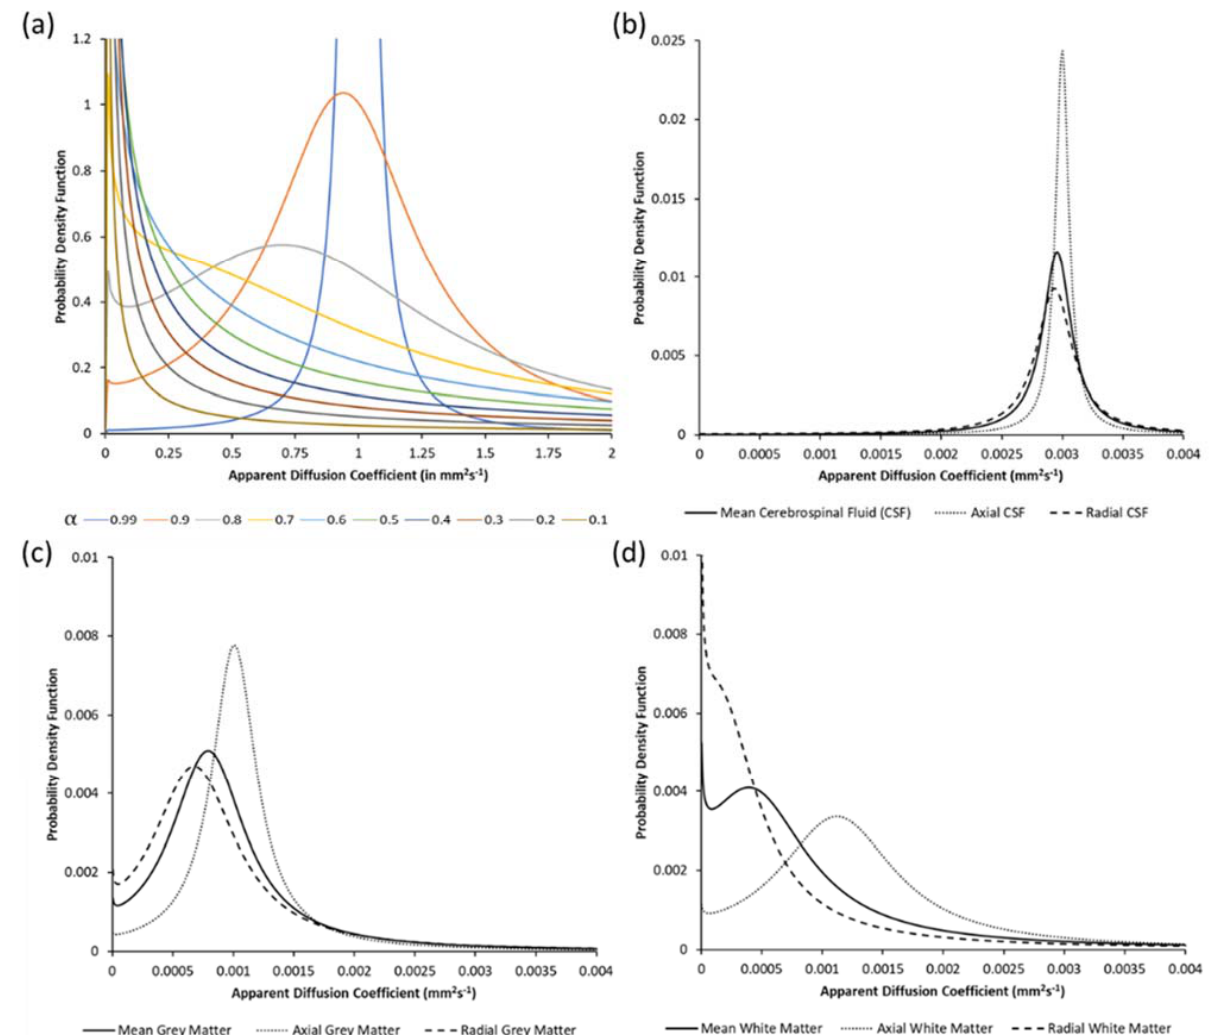
Figure 3. Decomposition of the signal into a spectrum of Fickian apparent diffusion coefficients via the inverse Laplace transform. Graph ( a ) shows the probability density functions for a unit diffusion coefficient, D 1,2 = 1 mm 2 s − 1 for different fractional exponents, 0.1 ≤ α ≤ 0.99. Spectra are shown for axial, radial and mean D 1,2 and α values in ( b ) cerebrospinal fluid, ( c ) grey matter and ( d ) white matter. D 1,2 and α values used to calculate the spectra are from Barrick et al.